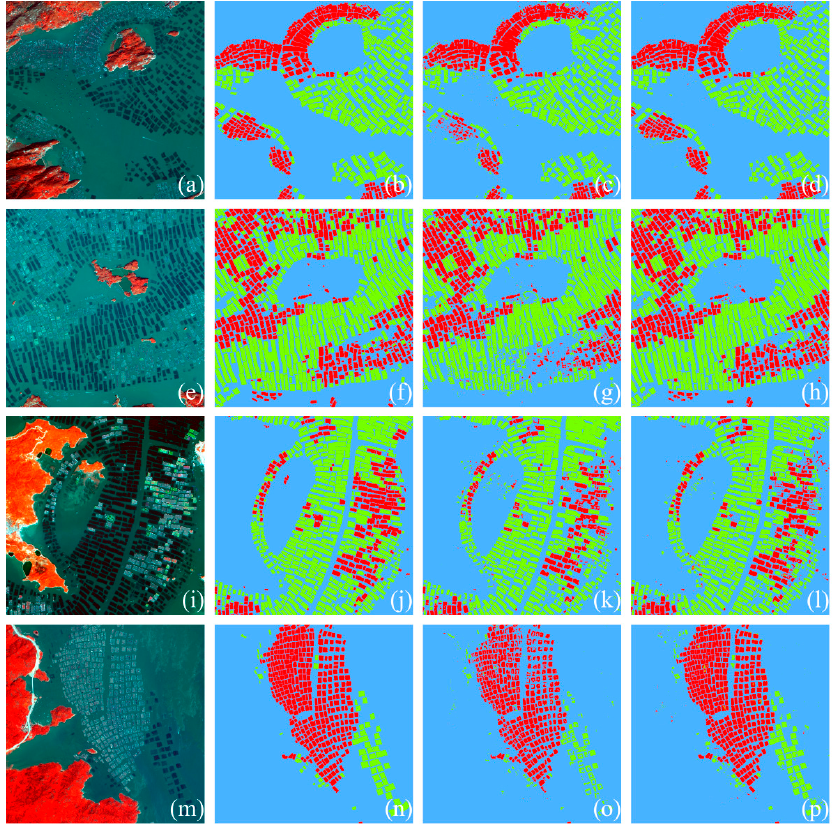
Figure 13. The images (false color: band combination 421), labels and extraction results of four test images. ( a ) Test A. ( b ) Label A. ( c ) DeepLab-v3+ experiment 2 of test A. ( d ) U-Net experiment 1 of test A. ( e ) Test B. ( f ) Label B. ( g ) DeepLab-v3+ experiment 2 of test B. ( h ) U-Net experiment 1 of test B. ( i ) Test C. ( j ) Label C. ( k ) DeepLab-v3+ experiment 2 of test C. ( l ) U-Net experiment 1 of test C. ( m ) Test D. ( n ) Label D. ( o ) DeepLab-v3+ experiment 2 of test D. ( p ) U-Net experiment 1 of test D.